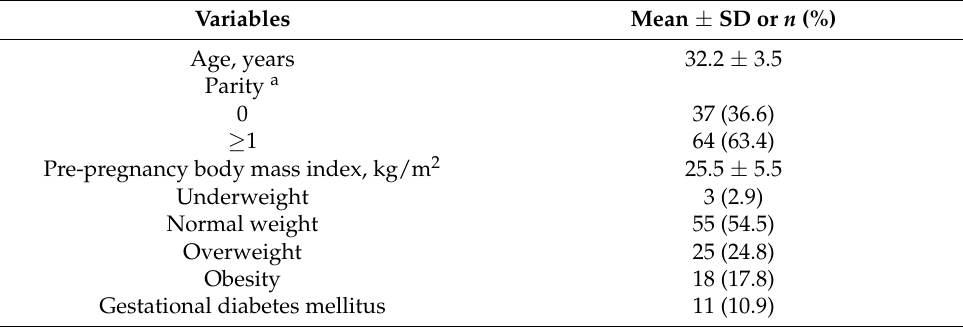
Table 1. Participants characteristics ( n =